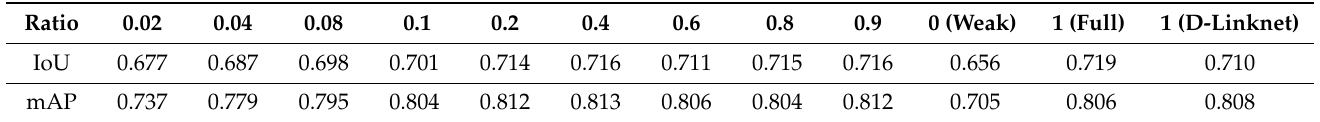
Table 5. Road Extraction Performance Using Different Ratios of fully supervised Annotation on Dataset 3.